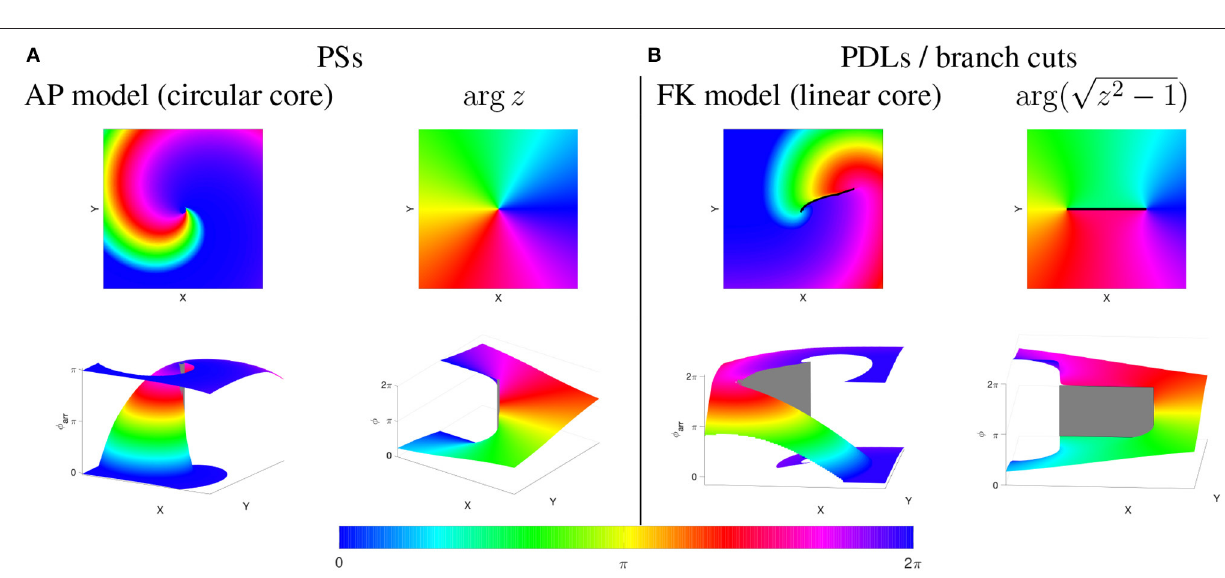
FIGURE 7 | Analysis of the simulated linear-core rotor from Figure 4 using LAT phase. (A) With φ arr , there are no sudden transitions in phase along the WF and WB, such that only CBLs are shown as phase defects, with large local phase gradient (B) .